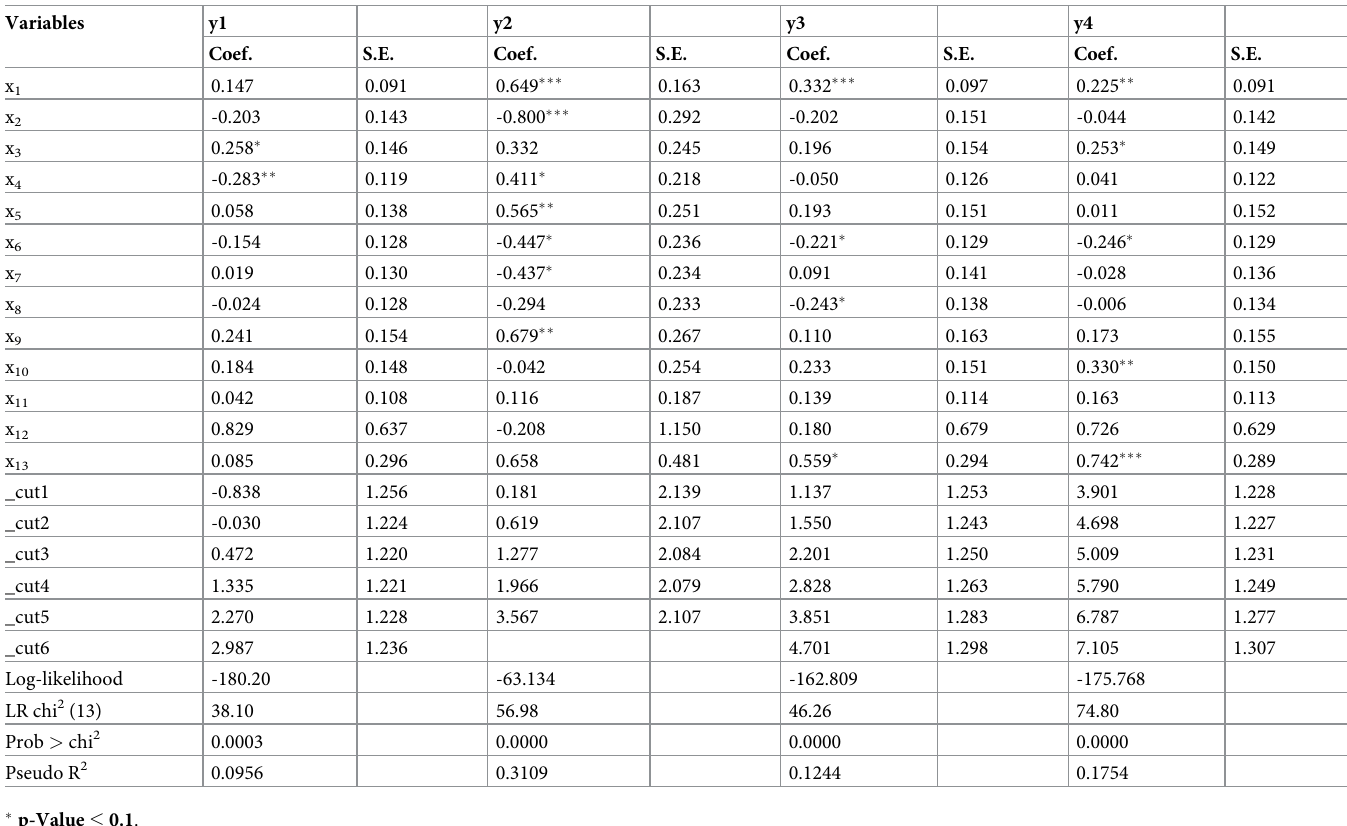
Table 5. Ordered logistic regression for SME goals during the coronavirus crisis